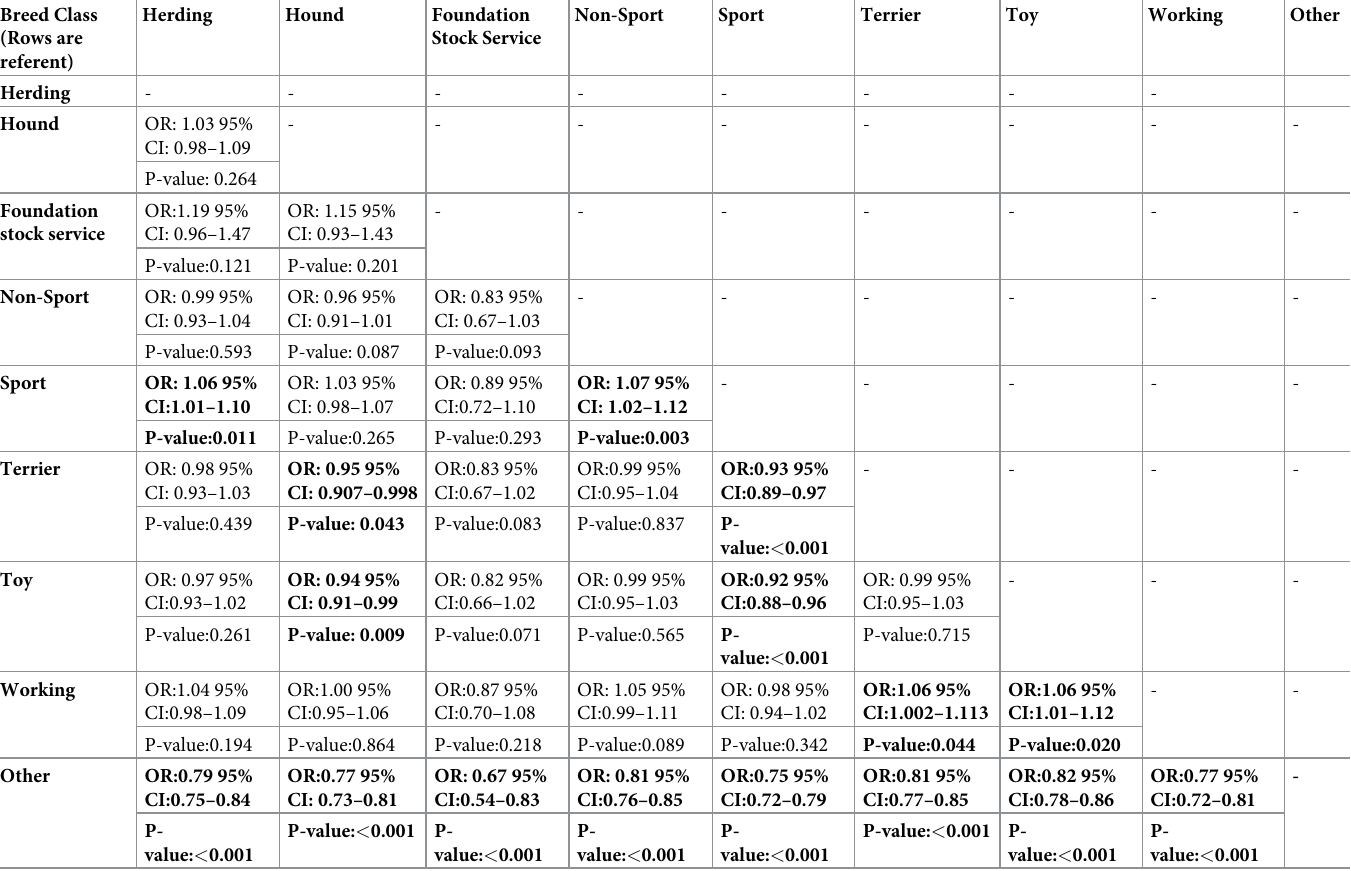
Table 4. Contrast table examining the associations between the breed classes on the odds of a poisoning call to the APCC being from a veterinarian than a pet owner. Breed Class Hound Foundation Non-Sport Sport Terrier Toy Working Other (Rows are Stock Service